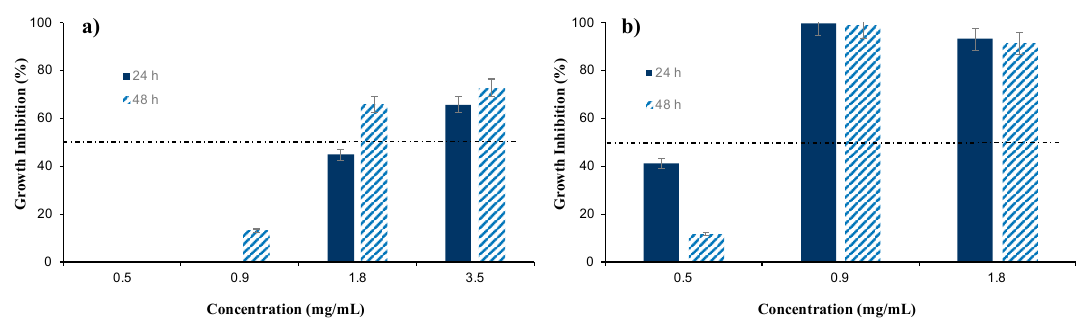
Figure 3. Antimicrobial activity of the biosurfactant extracted from corn steep water (CSW) ( a ) before a filtration stage (NFBS) and ( b ) after a filtration stage (FBS) against P. aeruginosa after 24 and 48 h of incubation. The results represent the average of triplicate experiments ± standard deviation.